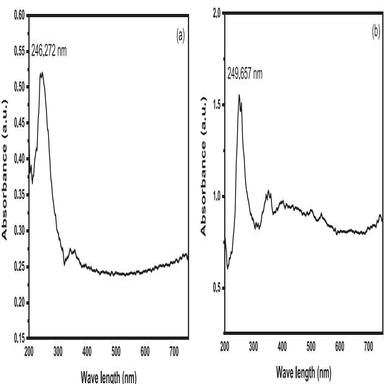
The UV–visible absorption spectra of (a) 2 sccm and (b) 5 sccm nitrogen doped graphene on glass substrate.